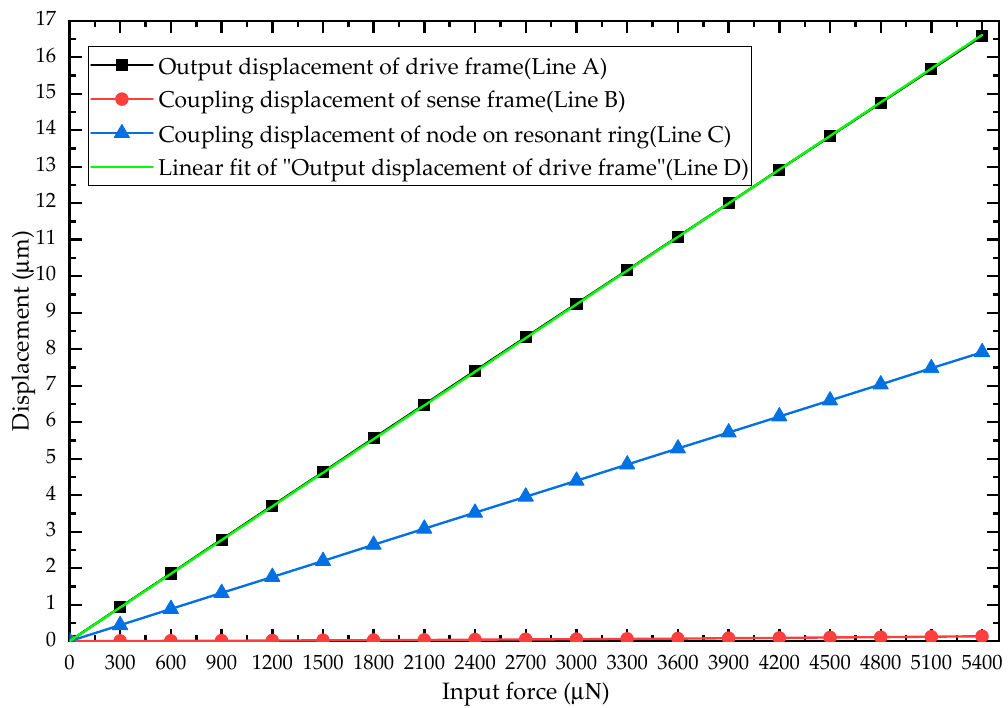
Figure 10. The output displacement of drive frame (Line A), sense frame (Line B) and node of resonant ring (Line C) at di ff erent input forces as well as linear fit of measured data (Line ring (Line C) at different input forces as well as linear fit of measured data (Line D).